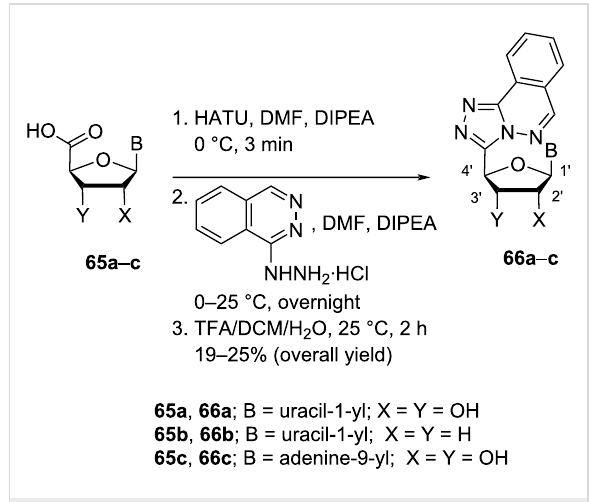
Scheme 15: Synthesis of double-headed nucleosides 66a–c .